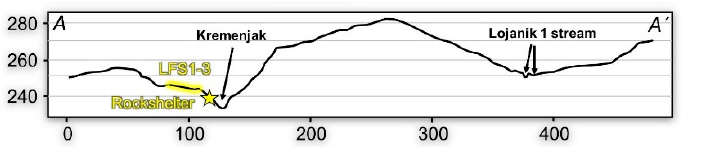
Figure 1. Study region: ( a ) Geomorphological map displaying the main Geological Units (GU) mapped during our survey, based on the LiDAR data. ( b ) Detail from the Kremenjak Valley showing Lojanik 2 (L2), our Lithic Find Spots (LFS) from Lojanik 3 (L3), and the Electrical Resistivity Tomographies (ERT) displayed in Figure “ERT1”. ( c ) Detail from the Lojanik 1 Valley displaying Lojanik 1 (L1), our Geotrench, and the ERT data exhibited in Figure “ERT2”. A–A ′ topographic section across the two valleys, location in detail ( a ).